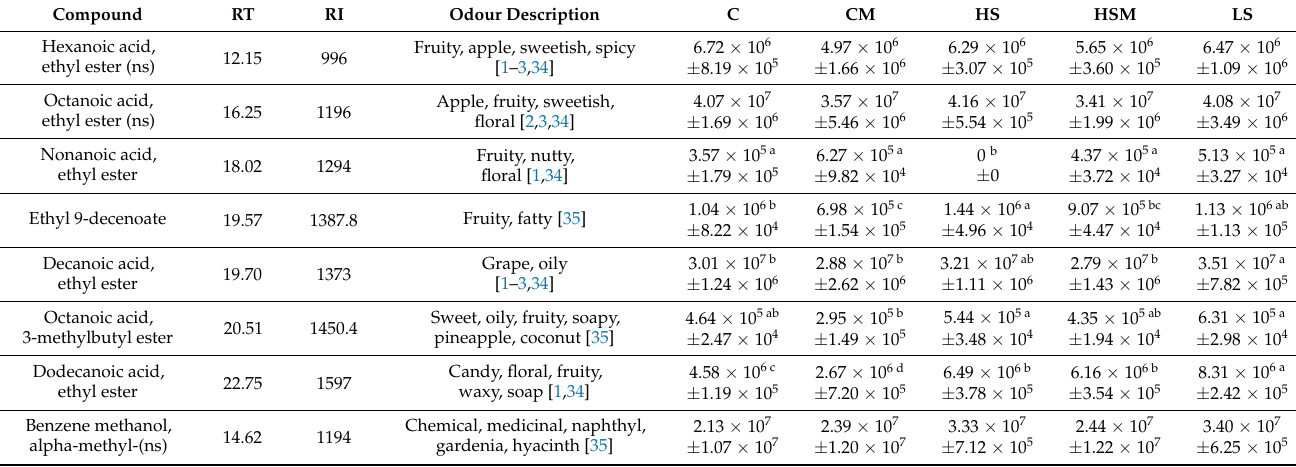
Table 1. Aromatic compounds detected from the GC–MS analysis showing their odour description, mean peak area (top), and standard error